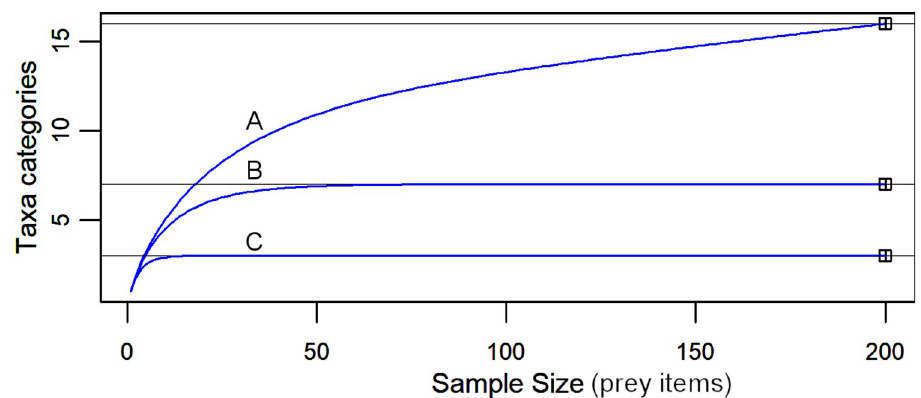
Fig 2. Accumulation curves for pooled jaguar diet, at three levels of taxa classification. (A) Fine-scale, 16 categories: lowest order taxa identifiable; the number of taxa does not asymptote below N = 200 prey items; (B) Medium-scale, seven categories: six principle prey groups (nine-banded armadillo, white-nosed coati, white-lipped peccary, collared peccary, paca, and domestic ungulates) and one pooled group of rare prey (each species with relative occurrence < 5%); the number of taxa reaches 6.99 with N = 89 prey items, and asymptotes at 7 taxa with N = 153 prey items; (C) Broad-scale, three categories: species > 10kg (ungulates), nine-banded armadillo, and other species � 10kg; the number of taxa reaches 2.99 with N = 18 prey items, and asymptotes at 3 taxa with N = 48 prey items. N = 200 independent prey items of 16 known taxa from 30 jaguars; scats collected from 2003 to 2006 in and around the Cockscomb Basin Wildlife Sanctuary,